Question: Describe this figure in one sentence.
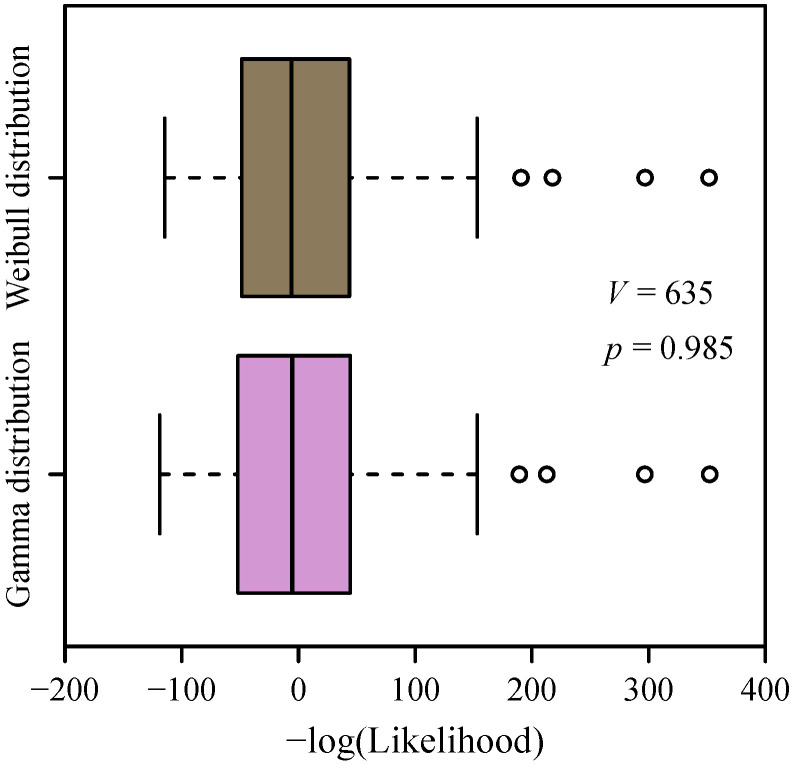
Answer: Comparison of the negative natural logarithm of likelihood values of fitting the Gamma and Weibull distributions. The paired non-parametric Wilcoxon signed-rank test was used to test the significance of the difference in the log(likelihood) values between the two distributions.